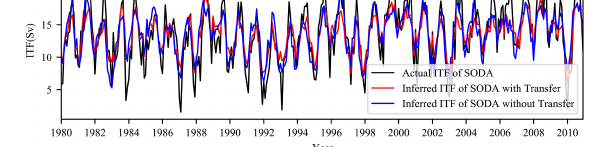
FIGURE 6 Comparison between CNN-inferred SODA with transfer (red), CNN- inferred SODA without transfer (blue), and actual ITF transports of SODA